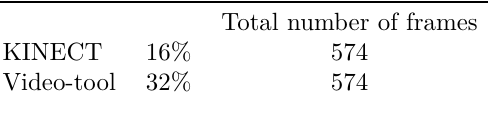
Table 5. Rate of frames without detected